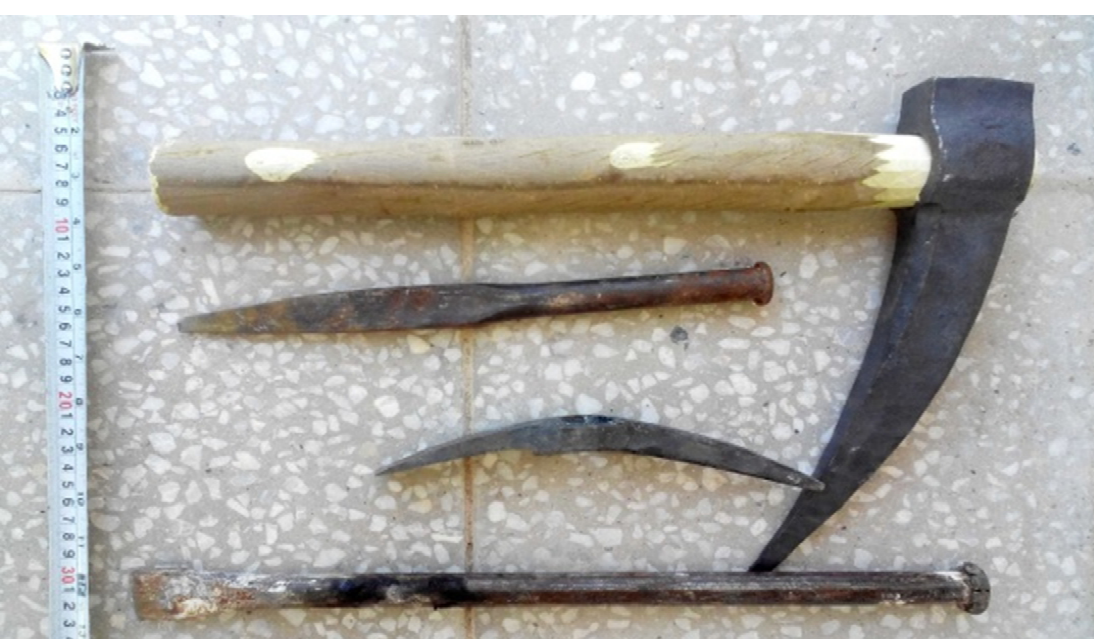
Figure 7. Sample of equipment used for excavation.